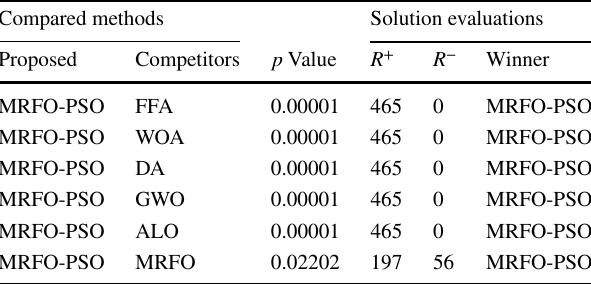
Table 9 Wilcoxon’s test for the reported results in Tables 4 and 5 Compared methods